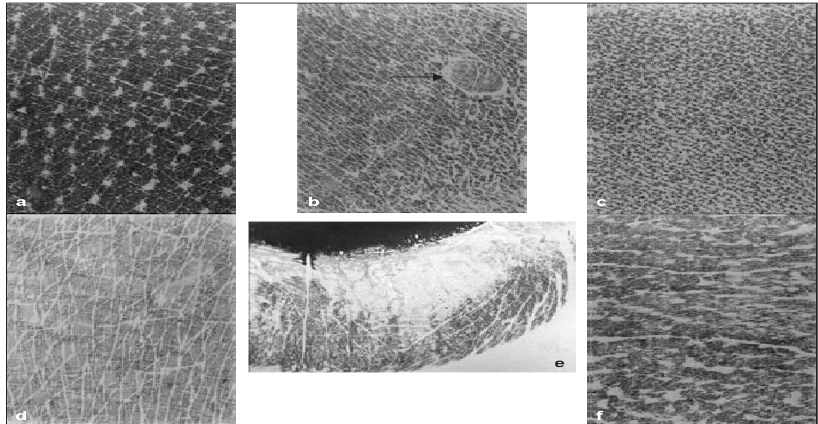
Figure 1. Capacitance imageing of skin surface at six anatomical sites. ( a ) Lateral side of the neck, ( b ) Abdomen. The arrow points to a ruby angioma appearing as a circumscribed lesion with an altered pattern of skin linenetwork. ( c ) Inner aspect of the arm with a very dense network of microrelief lines. ( d ) Dorsum of the hand, ( e ) Lower lip, ( f ) Forehead